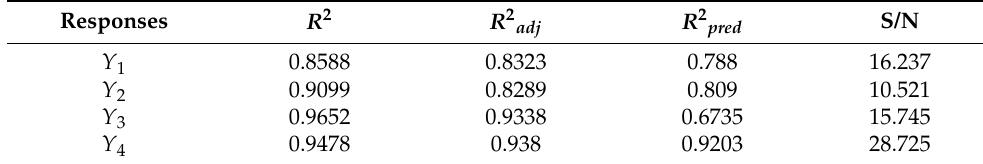
Table 2. Model fitness for